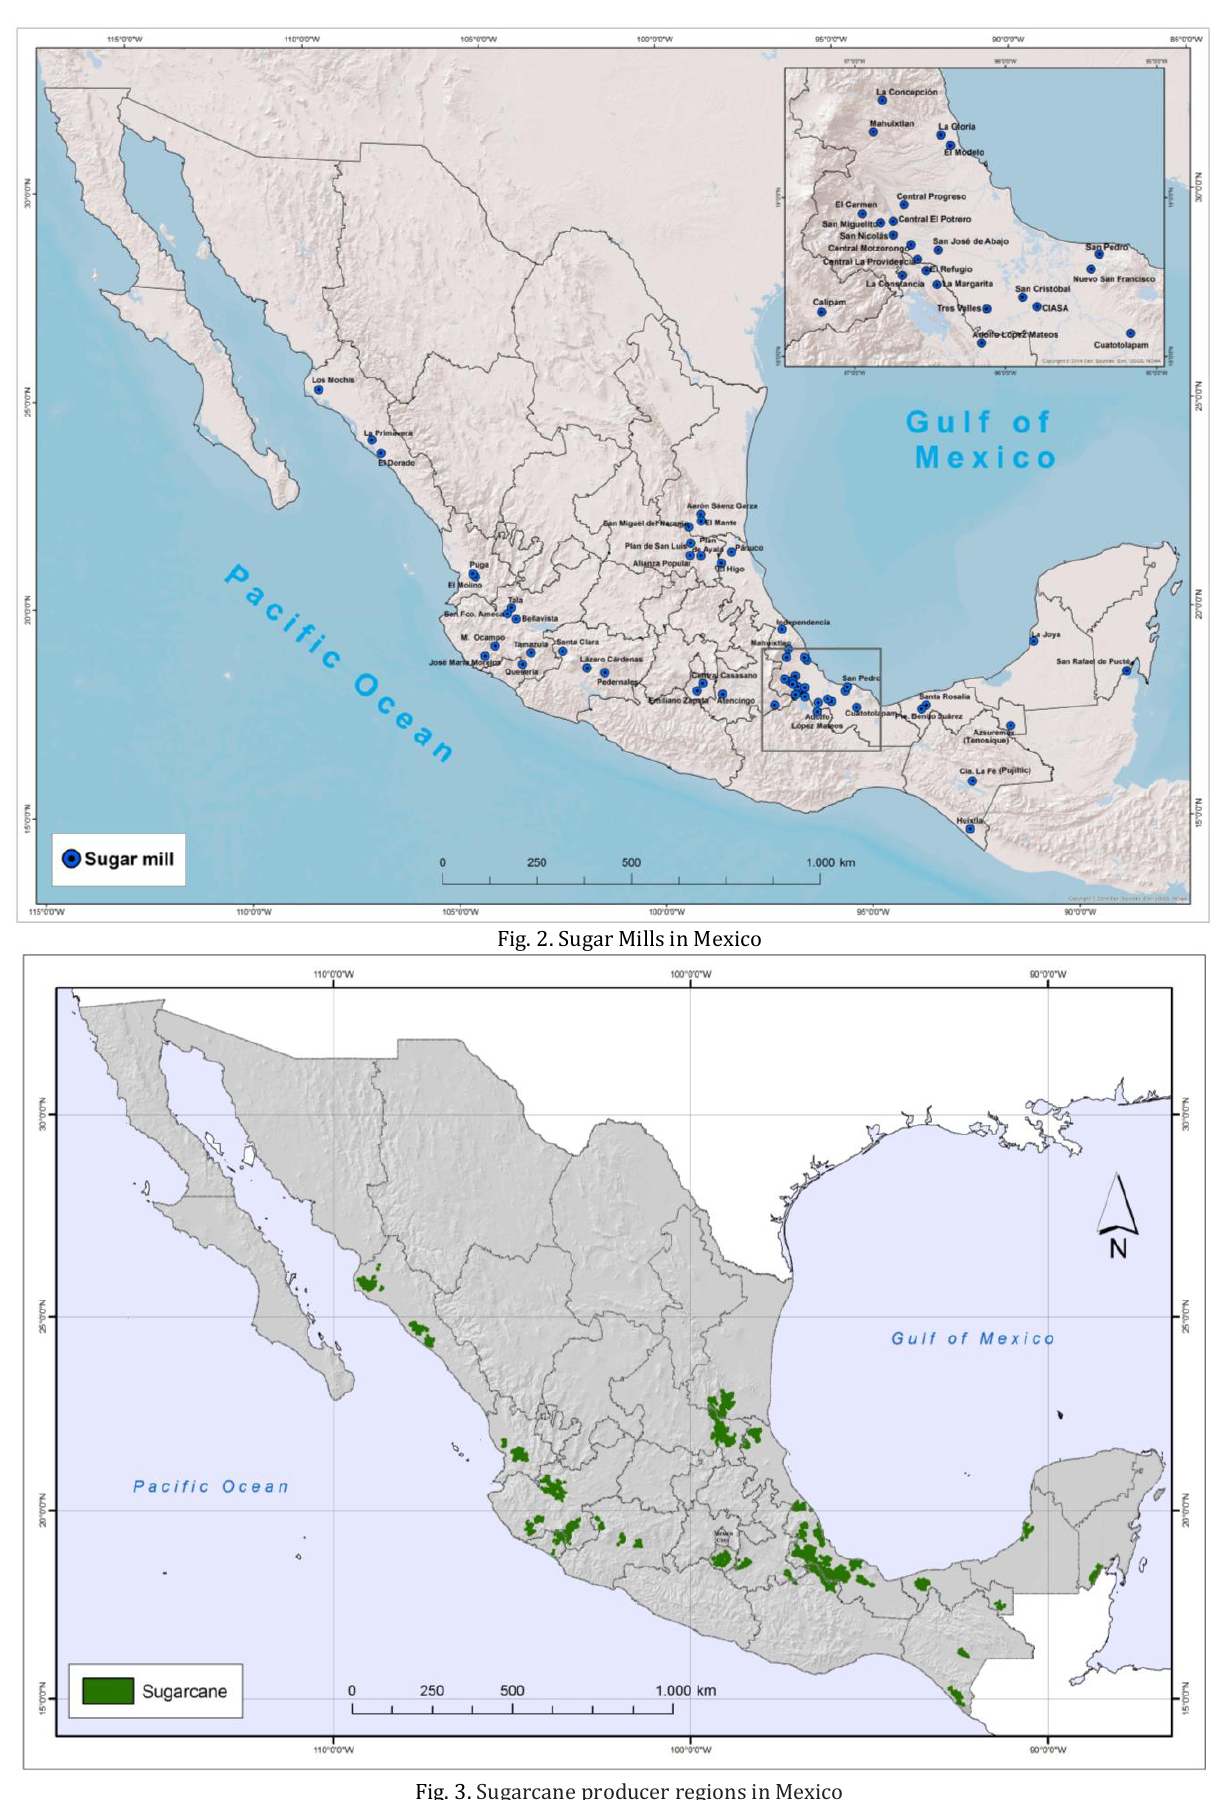
Fig. 3. Sugarcane producer regions in